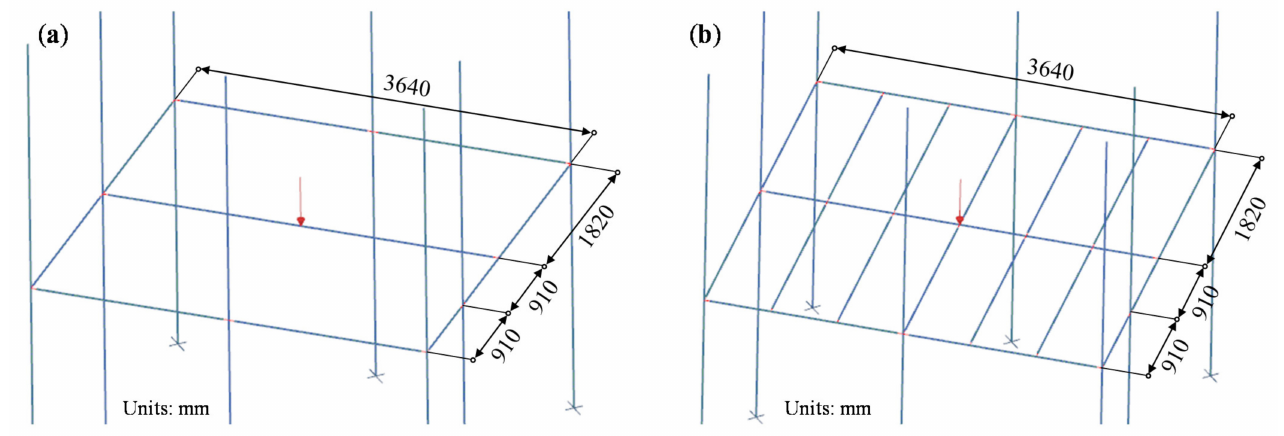
Figure 10. Schematics of ( a ) beam structure 1 and ( b ) beam structure 2.